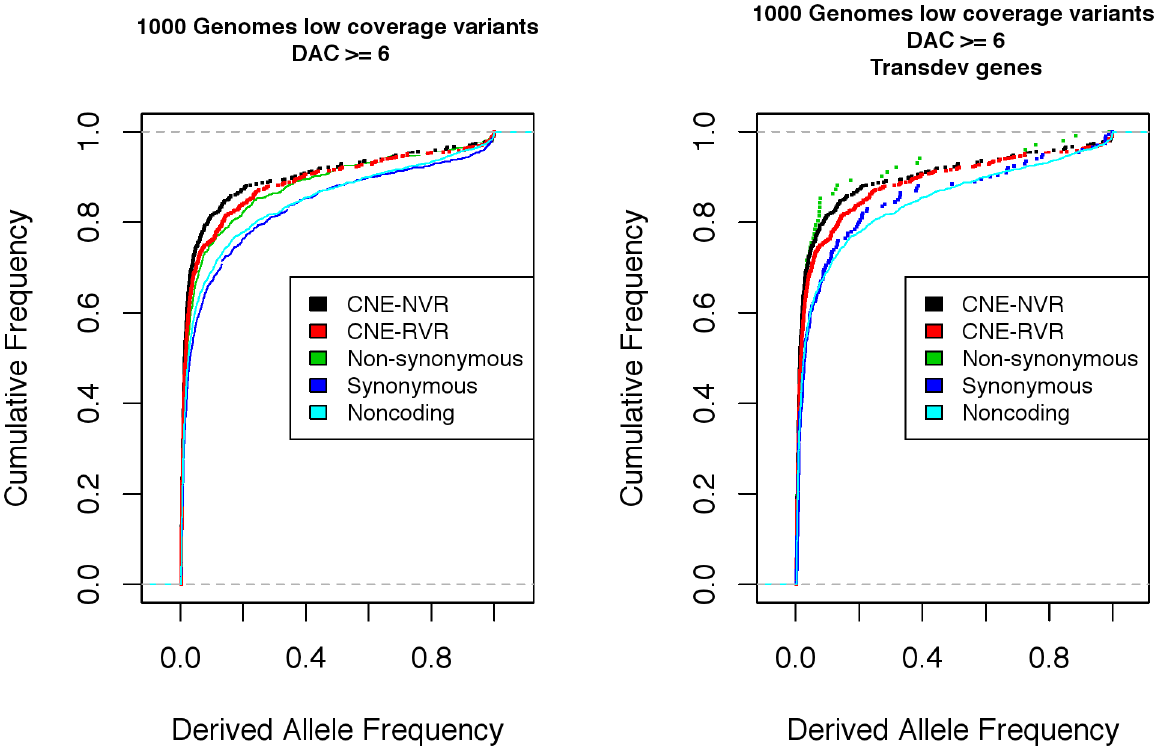
Figure 1. Cumulative derived allele-frequency in CNEs and control regions from 1000 Genomes Project. An excess of rare derived alleles is observed in CNE-NVRs, CNE-RVRs and Non-synonymous sites relative to Synonymous and Non-coding controls (using polymorphic sites with Derived Allele Count (DAC) . =6). The spectra at CNEs is comparable to the spectra at highly conserved trans-dev genes associated with CNEs. doi:10.1371/journal.pone.0103357.g001 PLOS ONE |